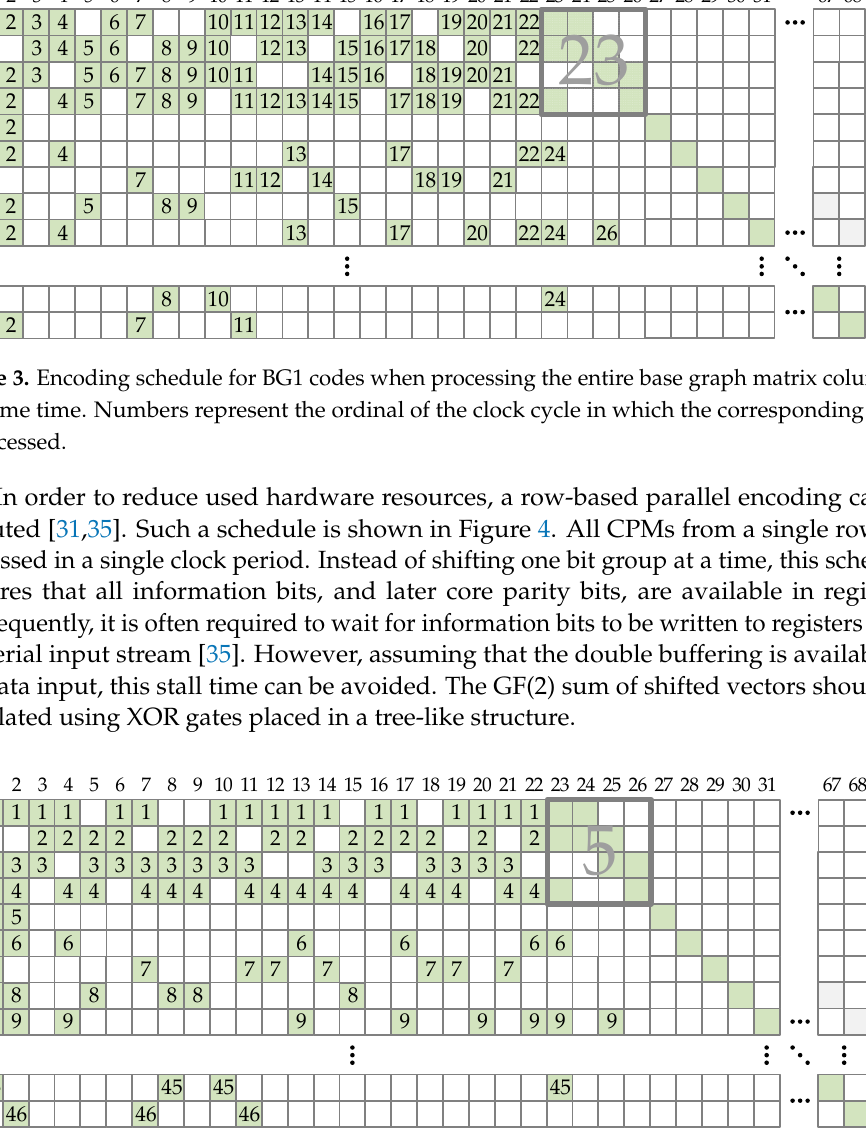
one clock period for core parity bits to be ready before the remaining four columns are